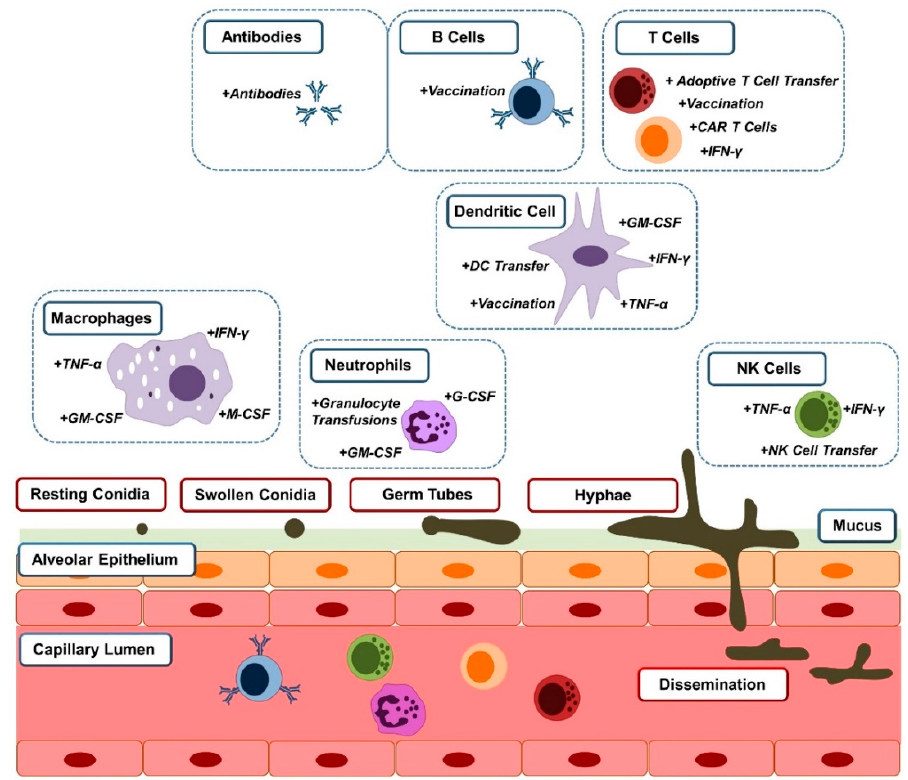
Figure 1. Cells of the innate and adaptive immune systems interact with different morphotypes of Aspergillus fumigatus . Macrophages clear resting and swollen conidia. Neutrophils attack all morphotypes of the fungus, while natural killer (NK) cells react to germ tubes and hyphae. Dendritic cells bridge the innate immune system to the adaptive immune system, which orchestrates fungal clearance of all morphotypes. Immunotherapeutic treatment options supporting these cells of the innate and adaptive immune systems are indicated next to the cell type they affect. Abbreviations: dendritic cell (DC); chimeric antigen receptor (CAR); granulocyte-macrophage colony stimulating factor (GM-CSF); granulocyte CSF (G-CSF); macrophage CSF (M-CSF); interferon (IFN) γ ; tumor necrosis factor (TNF) α .